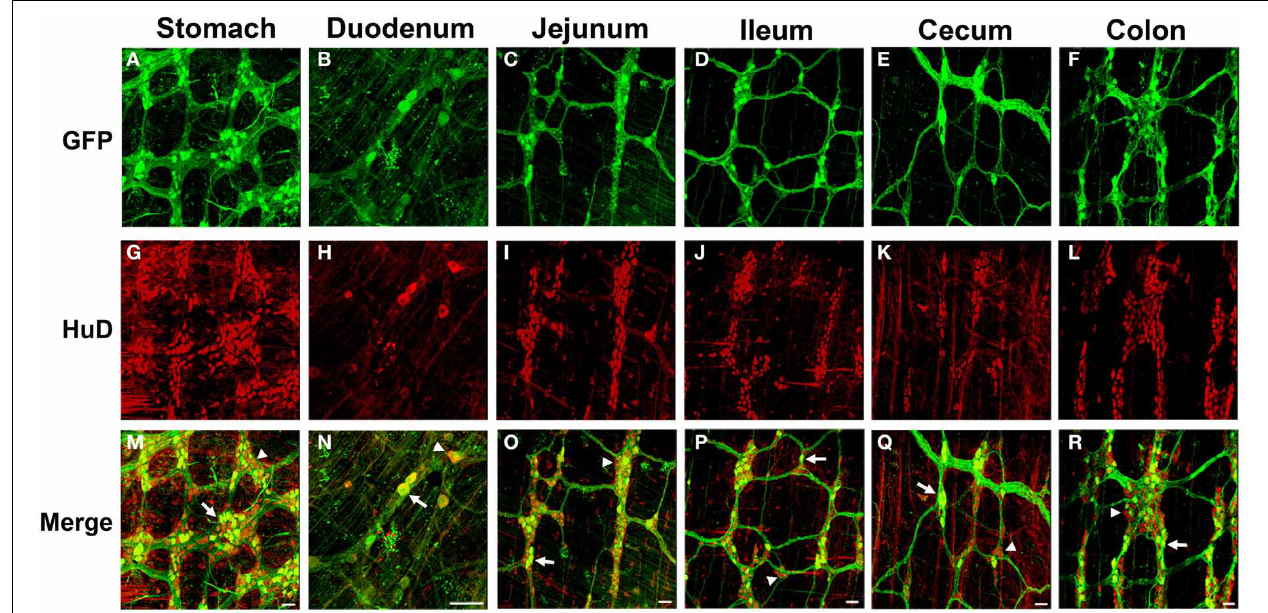
FIGURE 1 | Green fluorescent protein (GFP) expression in the myenteric plexus following intravenous injection of scAAV9-CB-GFP into neonatal mice. Intravenous injection of scAAV9-CB-GFP into P1 mice resulted in GFP (green, A–F ) expression in neurons (HuD, red, G–L ) in the